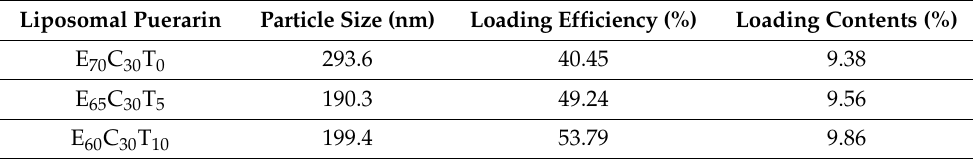
Table 5. The loading efficiency and contents of the puerarin in